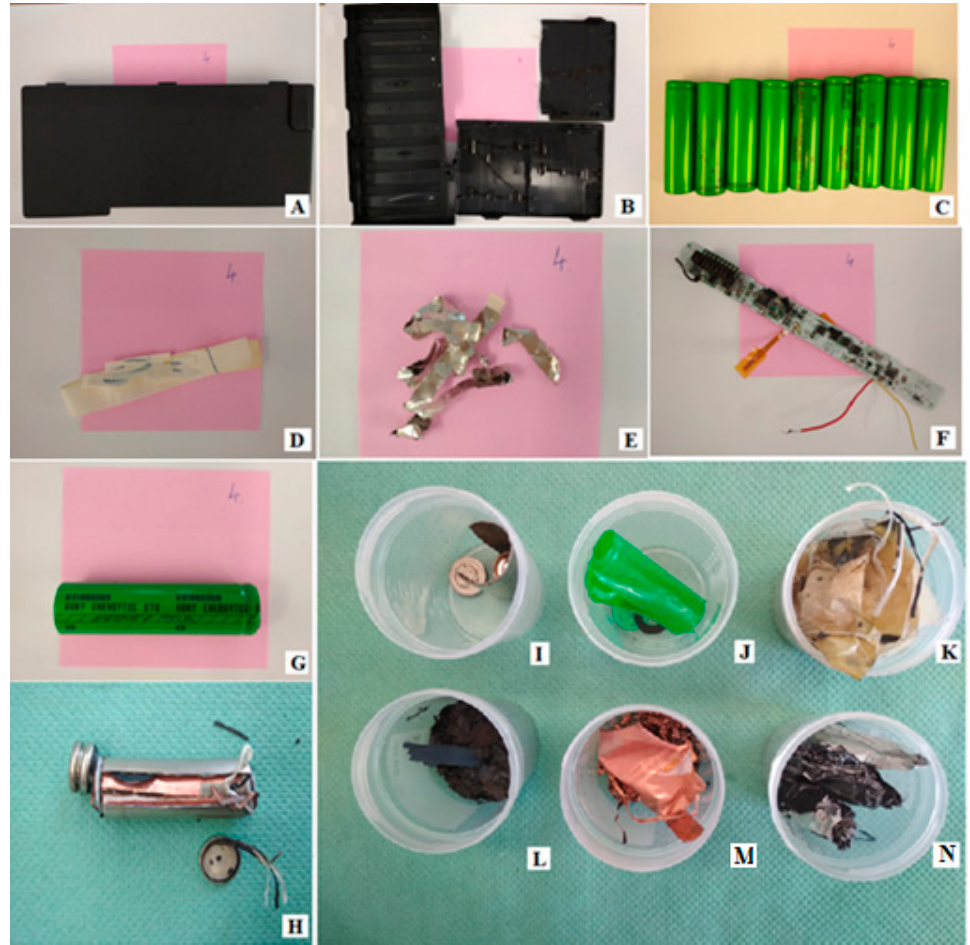
Figure 1. Mechanical treatment of a single spent lithium-ion cell. Stage I: ( A ) spent lithium-ion battery; ( B ) plastic case; ( C ) lithium-ion cells; ( D ) paper; ( E ) metals; ( F ) PCB and wires. Stage II: ( G ) single spent lithium-ion cell; ( H ) cell after cutting; ( I ) metal case; ( J ) cover and other plastics; ( K ) separator; ( L ) battery powder; ( M ) copper foil; ( N ) aluminum foil.